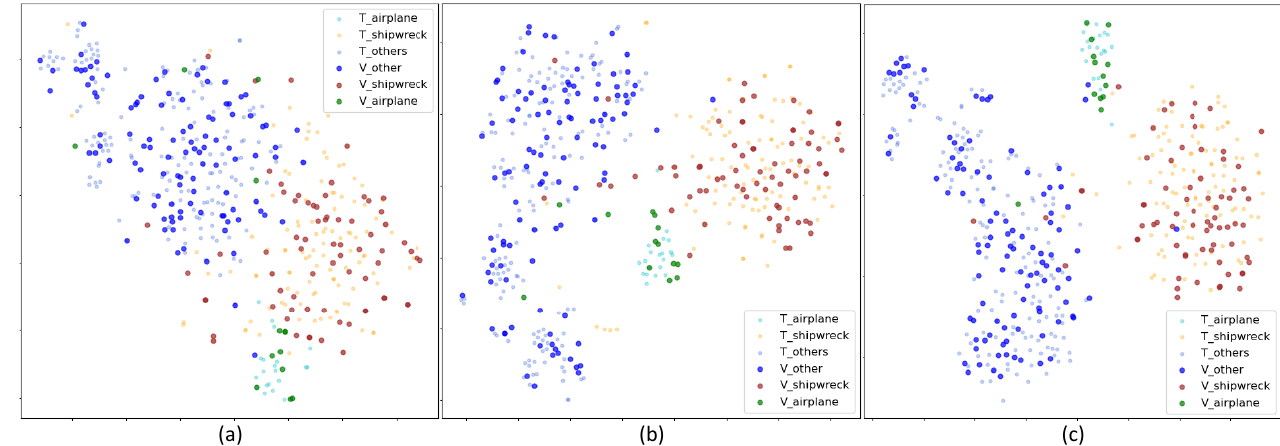
Figure 19. The t-SNE visualizations of deep features of the side-scan sonar image dataset: the T_aircraft, T_shipwreck, and T_other tags denote the features of training samples, and the V_aircraft, V_shipwreck, and V_other tags indicate the features of test samples. ( a ) Features extracted from C direct − train ; ( b ) features extracted from C basic − finetune ; and ( c ) features extracted from the classification network trained by our method.